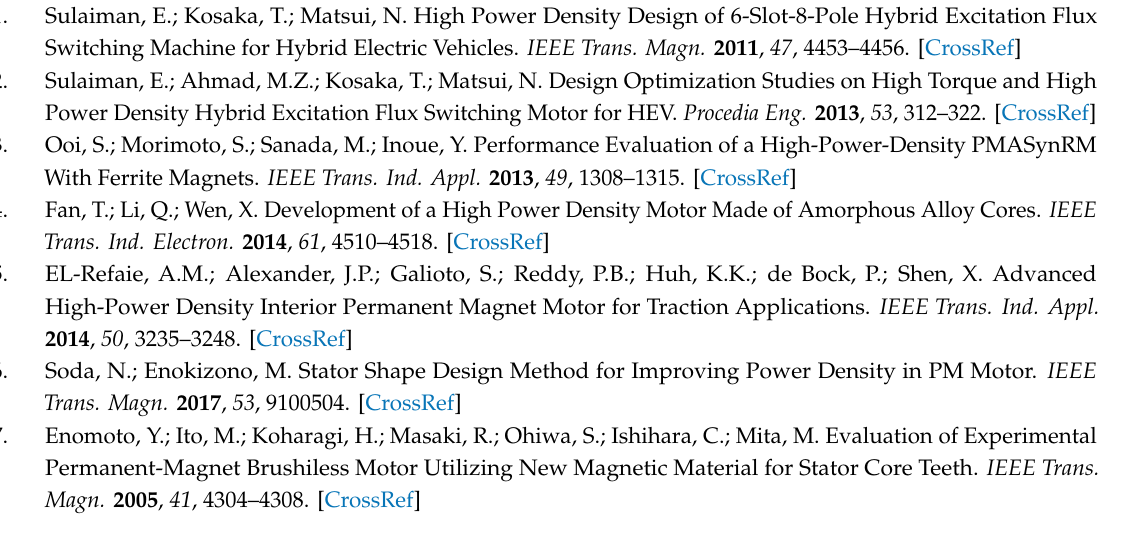
Figure 16. Power density for load angle of the base model, R1.25 model, and R1.50 model.